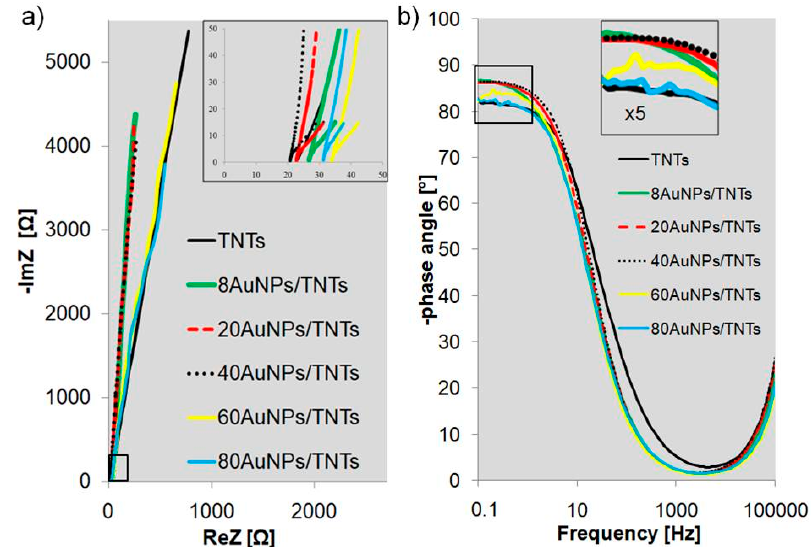
Figure 3. ( a ) Nyquist and ( b ) Bode plots for annealed TNT arrays before and after modification with AuNPs (n = 3) for different number of cycles.